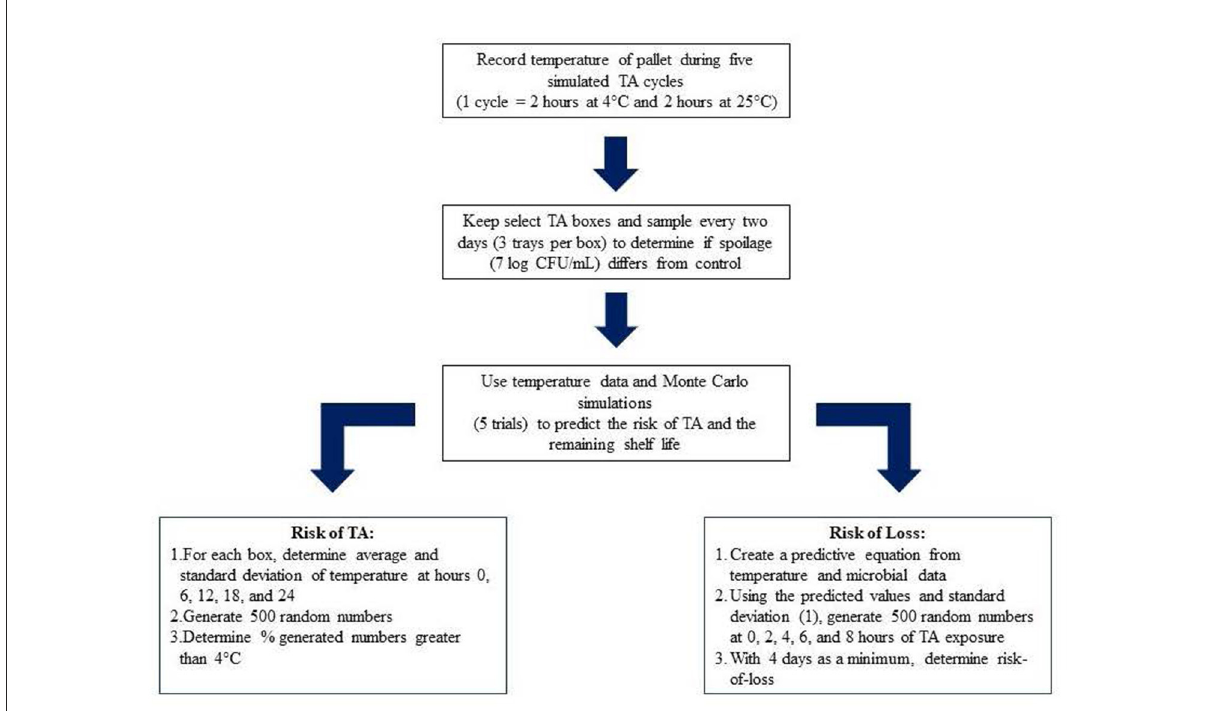
FIGURE1 Flow diagram of research methodology for the development predictive models of less-than-truckload temperature abuse.